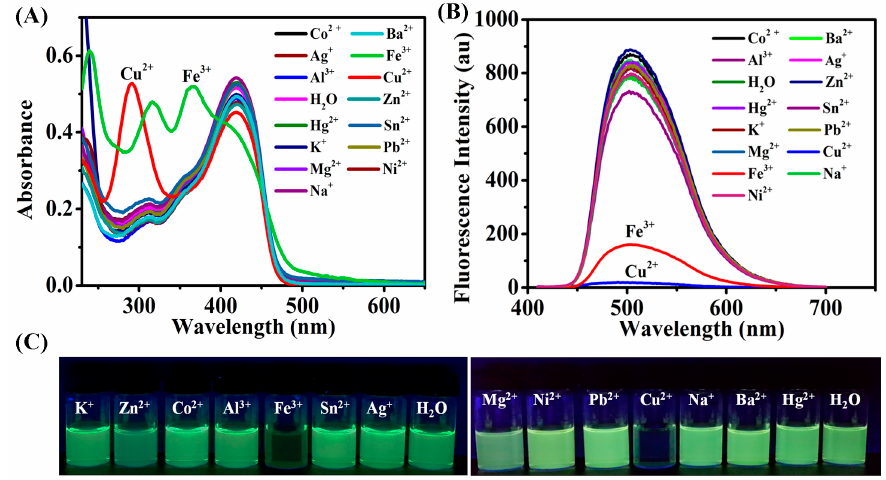
Figure 1. ( A ) UV–Vis spectra of PDBDBM sensor (1 × 10 − 5 mg/mL) and ( B ) fluorescence spectra collected in THF solution after adding various metal ions (150 μ M); ( C ) Fluorescence images of PDBDBM sensor (1 × 10 − 5 mg/mL) was taken under UV lamp irradiation after adding various metal ions.